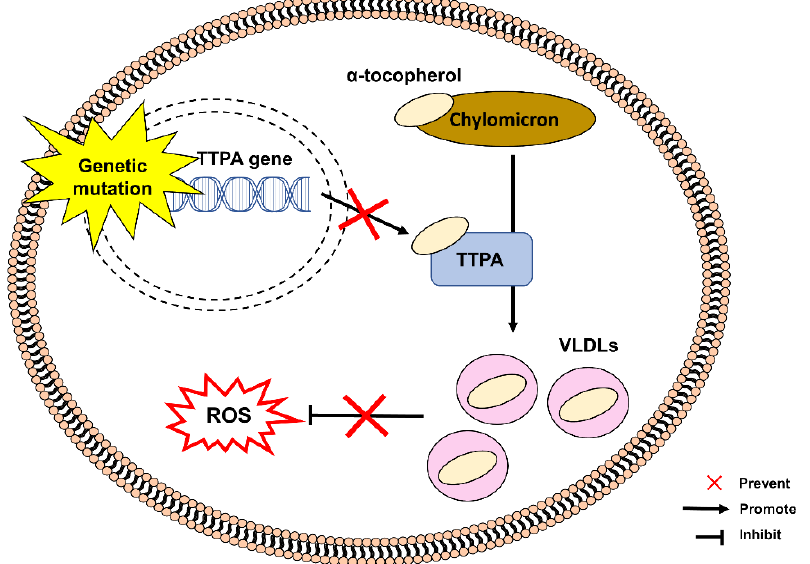
Figure 3. Mutation in the TTPA gene in the pathogenesis of AVED. An absence or deficiency of TTPA protein prevents the transfer of α -tocopherol from chylomicrons to very-low-density lipoproteins (VLDLs). Insufficient circulation of α -tocopherol contributes to vitamin E deficiency, which can increase the susceptibility to oxidative stress. TTPA, α -tocopherol transfer protein, VLDLs, very-low-density lipoproteins, ROS, reactive oxygen species.